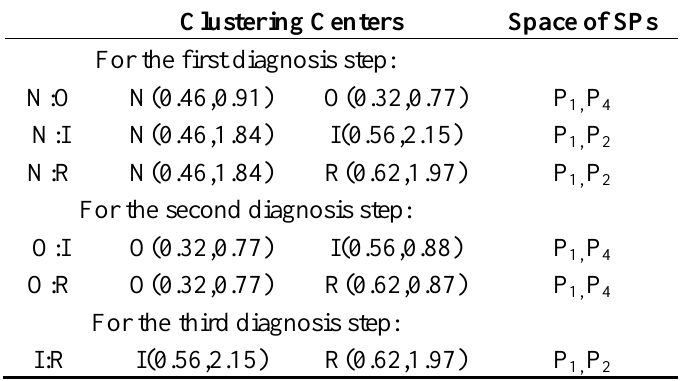
Table 3. Clustering centers for each sequential diagnosis step. Clustering Centers